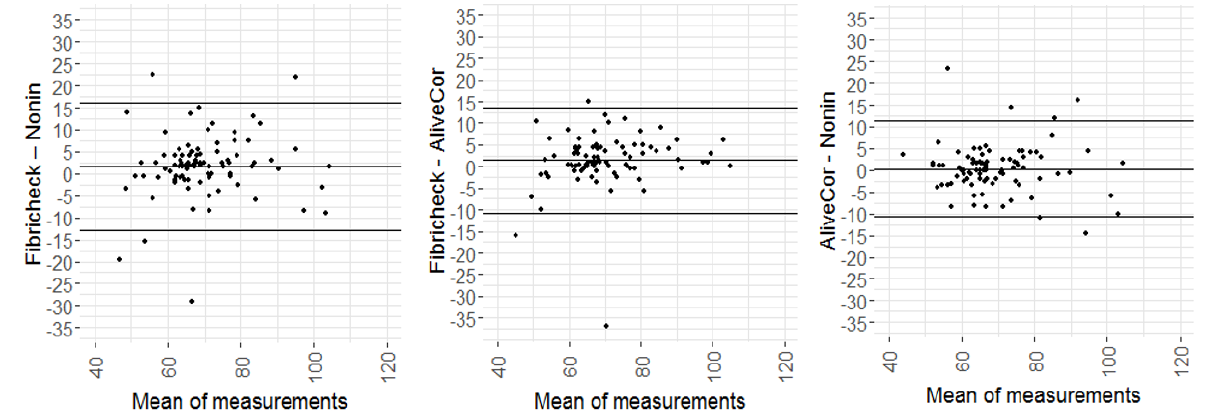
Figure 8. Bland-Altman plots for each device pair. The mean difference (bias), 1.96 (lower limit of agreement, LLA) and +1.96 standard deviations (upper limit of agreement, ULA) are plotted as full lines.